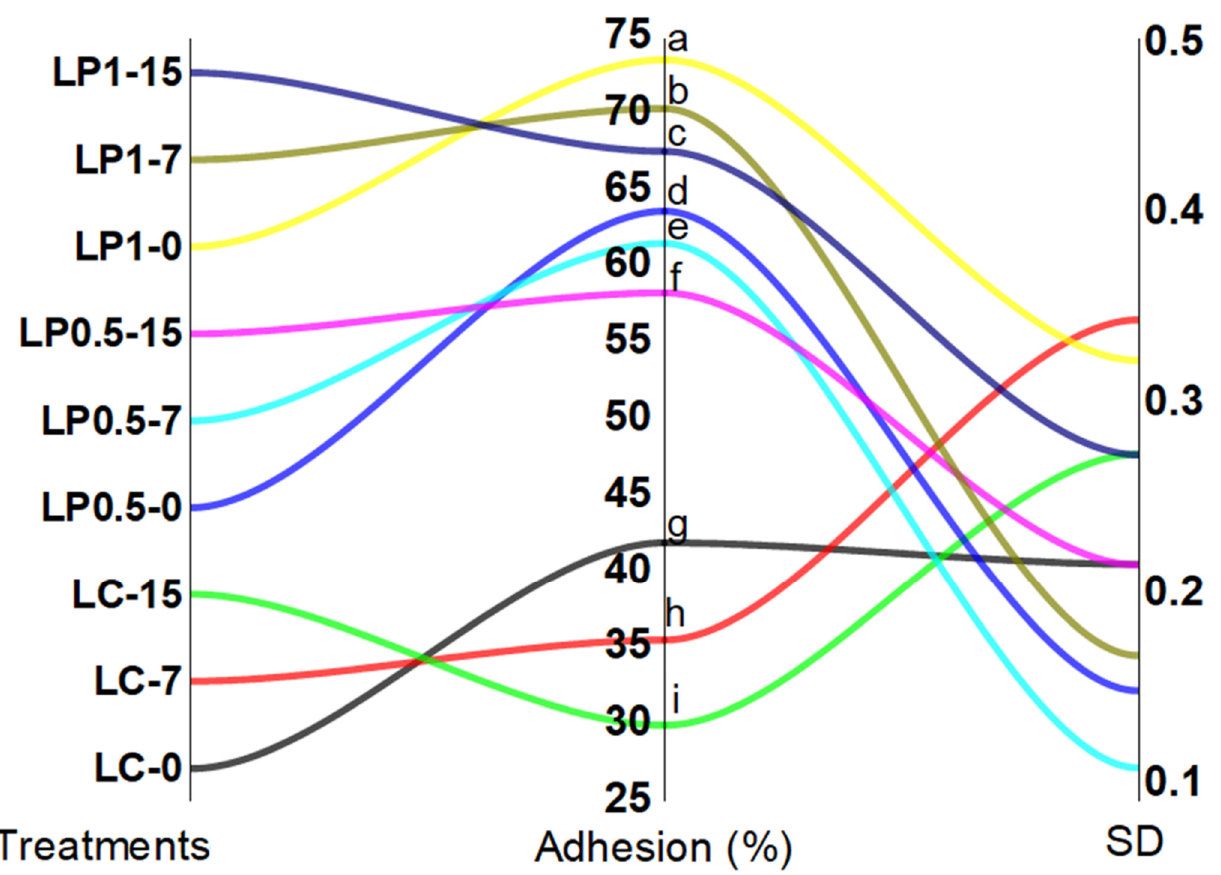
Figure 5. The effect of fortification of labneh with PFPP on the percentage of EcN adhesion to Caco-2 cells at different times of cold storage. LC, LP 0.5, and LP 1 denote plain labneh, labneh enriched with 0.5% of PFPP, and labneh enriched with 1.0%, respectively. The numbers 1, 7, and 15 indicate the time (days) of the cold storage period. a–i Different lowercase letters in the figure for each treatment indicate significant differences between treatments ( p ˂ 0.05).